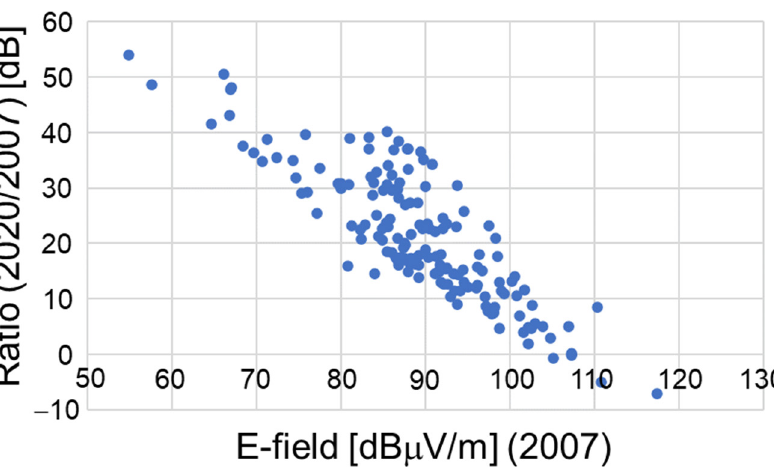
Figure 6. Ratio of E-field strengths in 2020 to those in 2007 point by point in all frequency